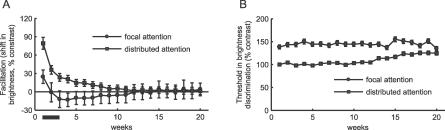
Experimental Predictions(A) Perceptual training with external feedback (starting after the first week) may separate bottom-up and top-down learning phases. The initial decrease in facilitation during the first week (bar from week 1 to 3) represents the fast learning progress based on the changes of the bottom-up connections from V1 to the decision network (see Figure 3A1). While trying to simultaneously maximize the performance for distributed and focal attention, facilitation will be overcompensated for focal attention (negative facilitation during the first weeks). This overcompensation arises when the time scales of the bottom-up and top-down learning are sufficiently different, and if the the stimulus presentations with distributed attention is more frequent than with focal attention (here, 85% distributed and 15% focal attention). In any case, the facilitation for both attentional states eventually disappears due to the slow top-down suppression of the lateral connections (from week 12 onward).(B) Sustained activation of GABA receptors by a GABA agonist disables the top-down induced gain increase in the pyramidal neurons (see [42]), modeled by fixing a unit gain of the L2/3 and L5 neurons, g = gx̃ = 1. As a consequence, the discrimination threshold remains high throughout the perceptual training without feedback (in contrast to the threshold reduction in Figure 4A2). The discrimination threshold for focal attention is even higher than for distributed attention because focal attention still drives the inhibitory neuron, and this reduces the network gain (positive k in Equation 5), without increasing the gain g and gx̃ of the pyramidal neurons.